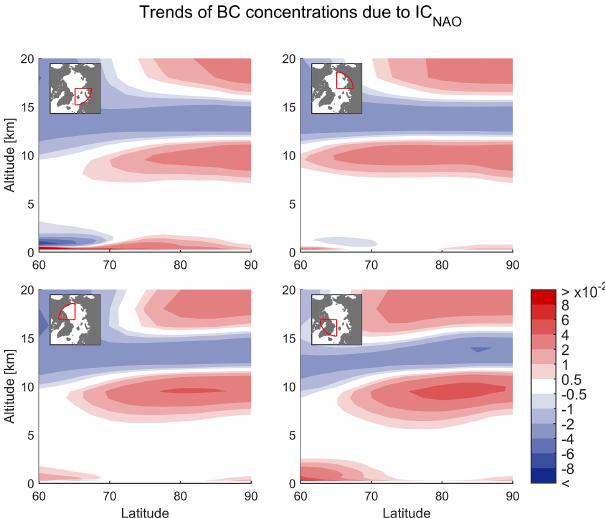
Figure 5. Winter (DJF) trends (1980–2015) of maximum like- lihood estimates of BC concentrations (ngkg − 1 yr − 1 ) associated with IC NAO circulation pattern. BC concentrations at each model vertical level and latitudes above 60 ◦ N are averaged over 90 ◦ lon- gitudes segments of the Arctic, indicated on the map on the left upper corner of each